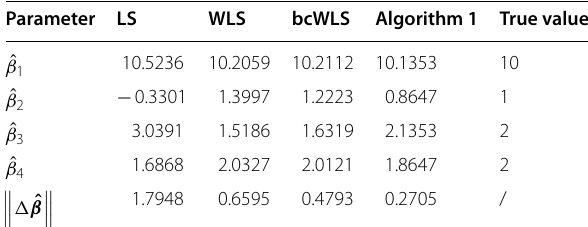
Table 4 Parameter estimates and the 2-norm results between the parameter estimates and true values for the first example Parameter LS WLS bcWLS Algorithm 1 True value